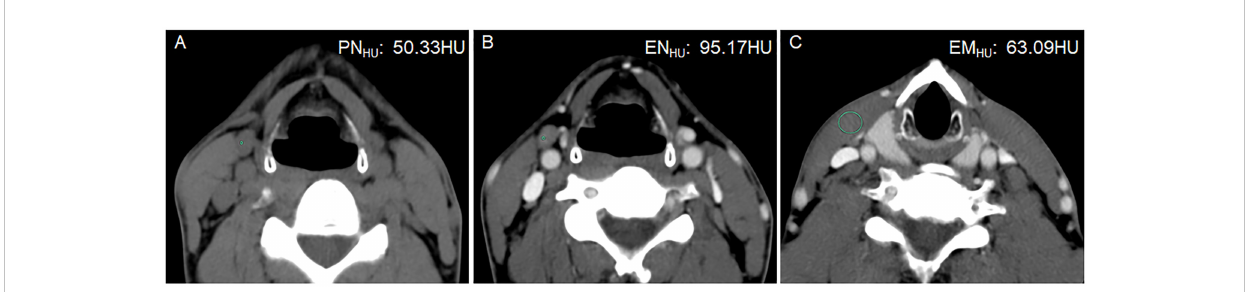
FIGURE 4 A 42-year-old man with PTC complicated with Hashimoto ’ s thyroiditis in the left lobe of the thyroid gland. Postoperative pathology con fi rmed that all lymph nodes in the right level III were metastasis negative. (A) PN HU was 50.33 HU. (B) EN HU was 95.17 HU. (C) EM HU was 63.09 HU. EN-PN HU, EN/PN HU , EN-EM HU , and EN/EM HU were 44.84 HU, 1.89, 32.08 HU, and 1.51, respectively.